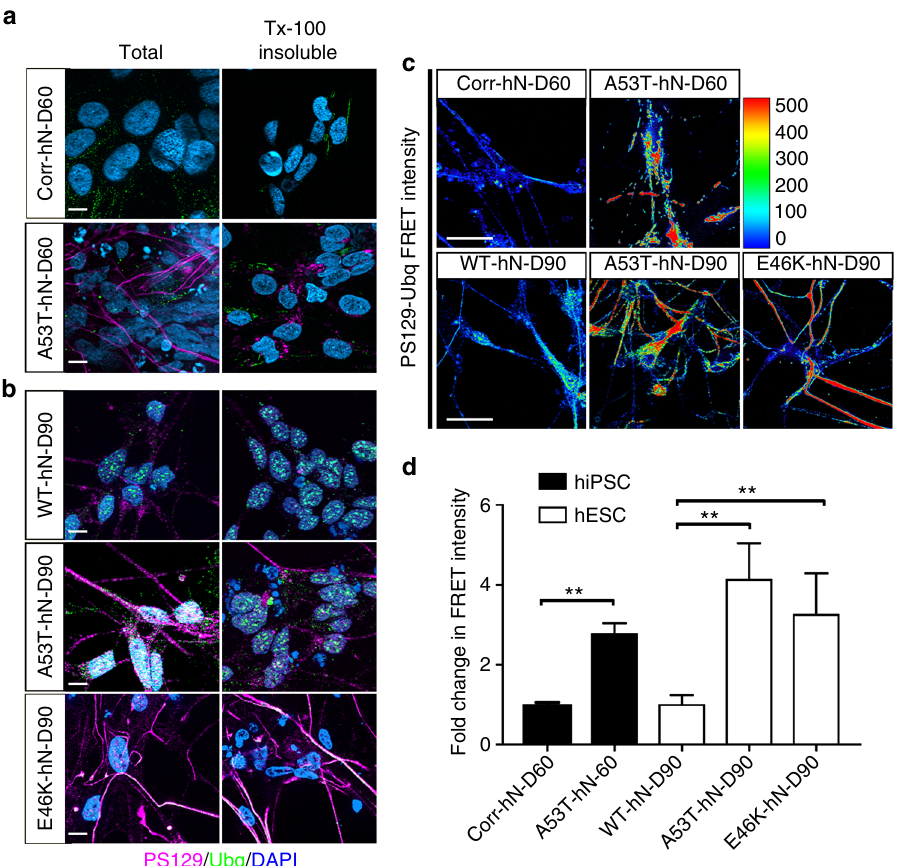
Fig. 1 α -Syn mutant hNs acquire early signs of α -syn pathology. a , b Accumulation of insoluble Ubq/ α -syn PS129 protein in hiPSC-derived A53T and corrected hNs ( a ) or hESC-derived WT, A53T and E46K hNs ( b ) was determined by TX-100 wash-out of soluble protein prior to fi xation. DIV: 60. Scale bar: 10 µ m. c , d Fluorescence resonance energy transfer (FRET) from Alexa-488-labeled ubiquitin to Alexa-594-labeled α -syn PS129 in hiPSC-derived A53T and corrected hNs or hESC-derived WT, A53T and E46K hNs was assessed and mean FRET intensity was quanti fi ed ( d ). Data represent mean ± s.e.m. ** P < 0.01 by ANOVA followed by Tukey ’ s post hoc test, n = 6 coverslips over three independent differentiations, DIV: 60 or 90. Scale bar: 50 µ